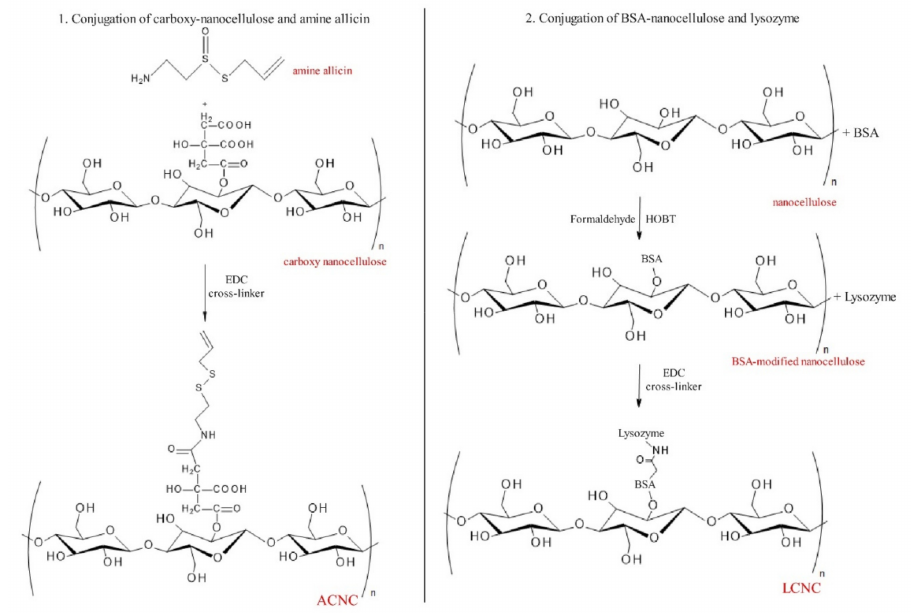
Figure 10. Schematic procedure of conjugation between nanocellulose, allicin, and lysozyme (summarized by